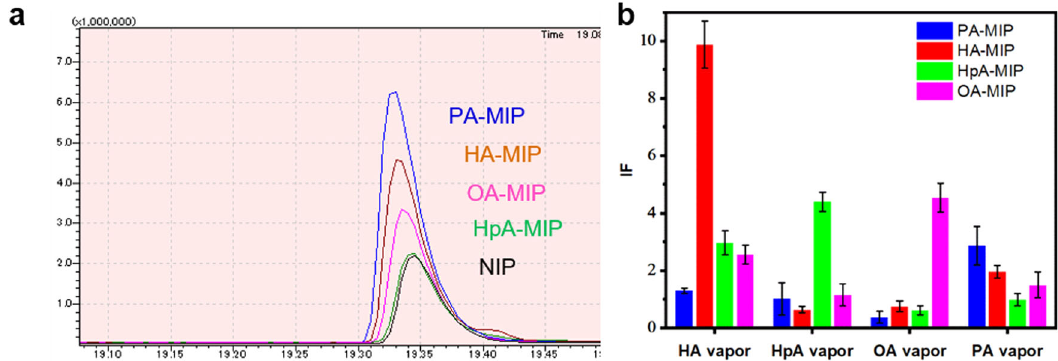
Fig. 4 Selectivity of MIPs. a Gas chromatography-mass spectrometry (GC-MS) results for the four types of MIP when exposed to PA vapors at 100 ppm. b Solid-phase microextraction (SPME)-GC-MS results for the four MIP types when exposed to four types of fatty acid vapor (PA/HA/ OA/HpA) at 100